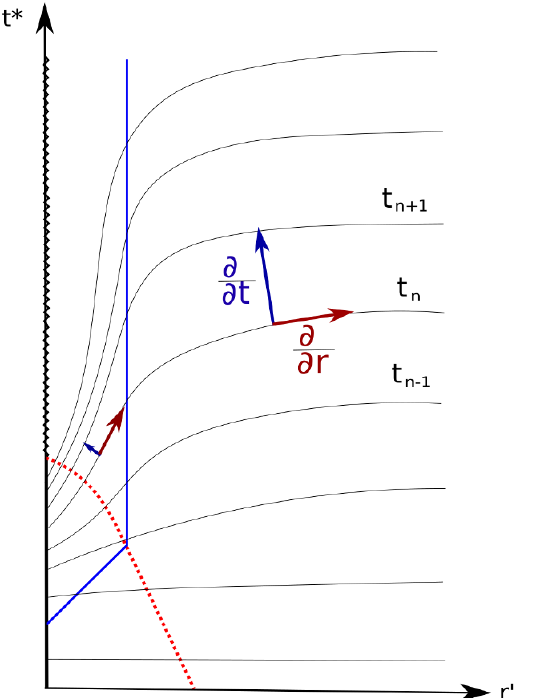
Figure 16 . A collapsing mass shell (red dashed line) and the horizon (blue solid line) in the in-going Eddington-Finkelstein coordinate system, where the transverse directions ( (cid:18); (cid:30) ) are suppressed. The metric outside the collapsing mass shell is given by the Schwarzschild metric, (cid:0) (cid:1) ds 2 = (cid:0) 1 (cid:0) 2 M dv 2 + 2 dr 0 dv + r 0 2 ( d(cid:18) 2 + sin (cid:18) 2 d(cid:30) 2 ) where t (cid:3) = v (cid:0) r 0 . The curves represent time r 0 slices which march forward with a constant lapse far from the black hole while avoiding the singu- (cid:0) @ (cid:1) larity inside the horizon. @ represents the vector (cid:12)eld that is tangential (perpendicular) @r @t